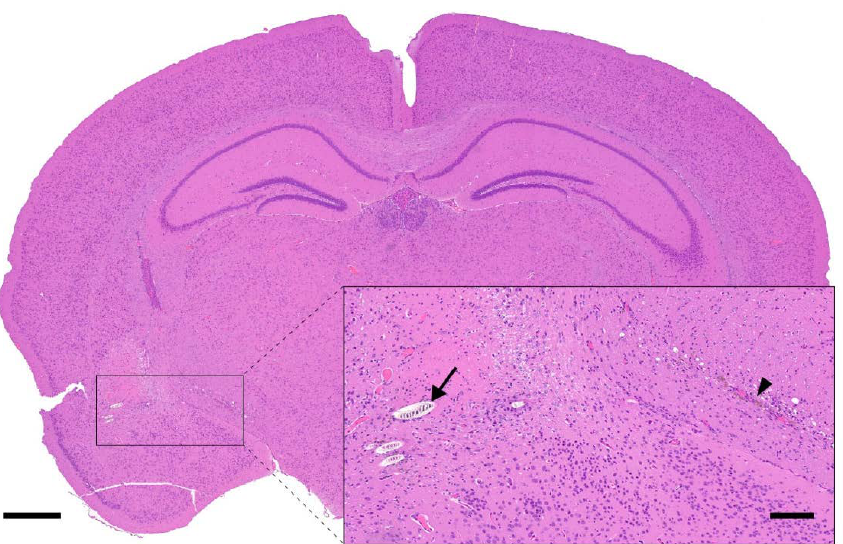
Figure 6. Deeper lesions associated with facial vein puncture. Photomicrograph of the brain of a mouse undergoing facial vein puncture with accidental penetration of the underlying cerebrum. The lesion in this mouse is associated with the introduction of hair shafts (black arrow, inset), mixed gliosis and minimal chronic hemorrhage (black arrowhead, inset). H&E stain. Left scale bar, 500 µ m; Inset scale bar, 100 µ